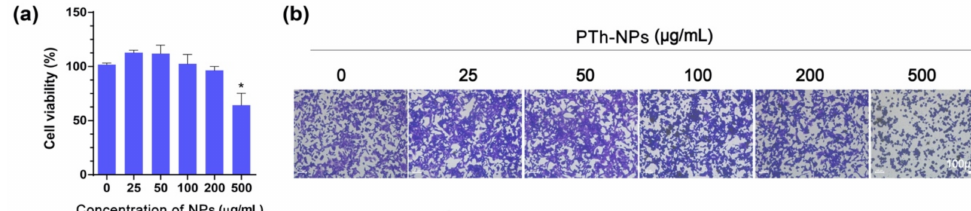
Figure 4. Cytotoxicity study of PTh–NPs. ( a ) Cell viability and ( b ) Crystal violet stained microscope images of CT-26 cell by treatment with PTh–NPs at concentration of (25, 50, 100, 200, and 500) µ g / mL. Each value is expressed as the mean ± standard deviation. * P < 0.05, when compared with the control.